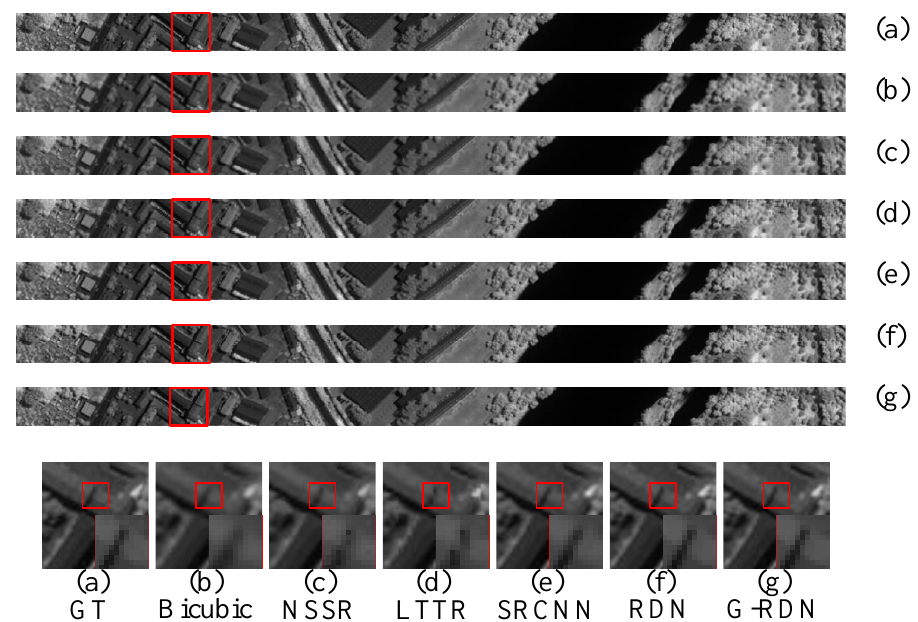
Figure 9. Visual exhibition of the reconstructed Pavia Center at the scaling factor of 2.